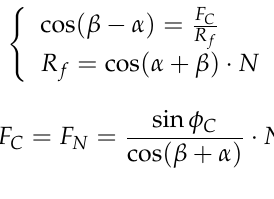
Figure 2. Friction vector diagram of the second deformation zone in EVC interface friction. The cutting force mainly comes from deformation and friction, that is, to overcome the resistance of the processed material to elastic deformation, plastic deformation, and the friction of the chip on the rake face. Based on the empirical equation of cutting force, we decompose the cutting force and synthesize the force moment vector diagram as shown in Figure 2. The main average cutting force is equal to the normal stress on the shear plane and can be obtained from Equation